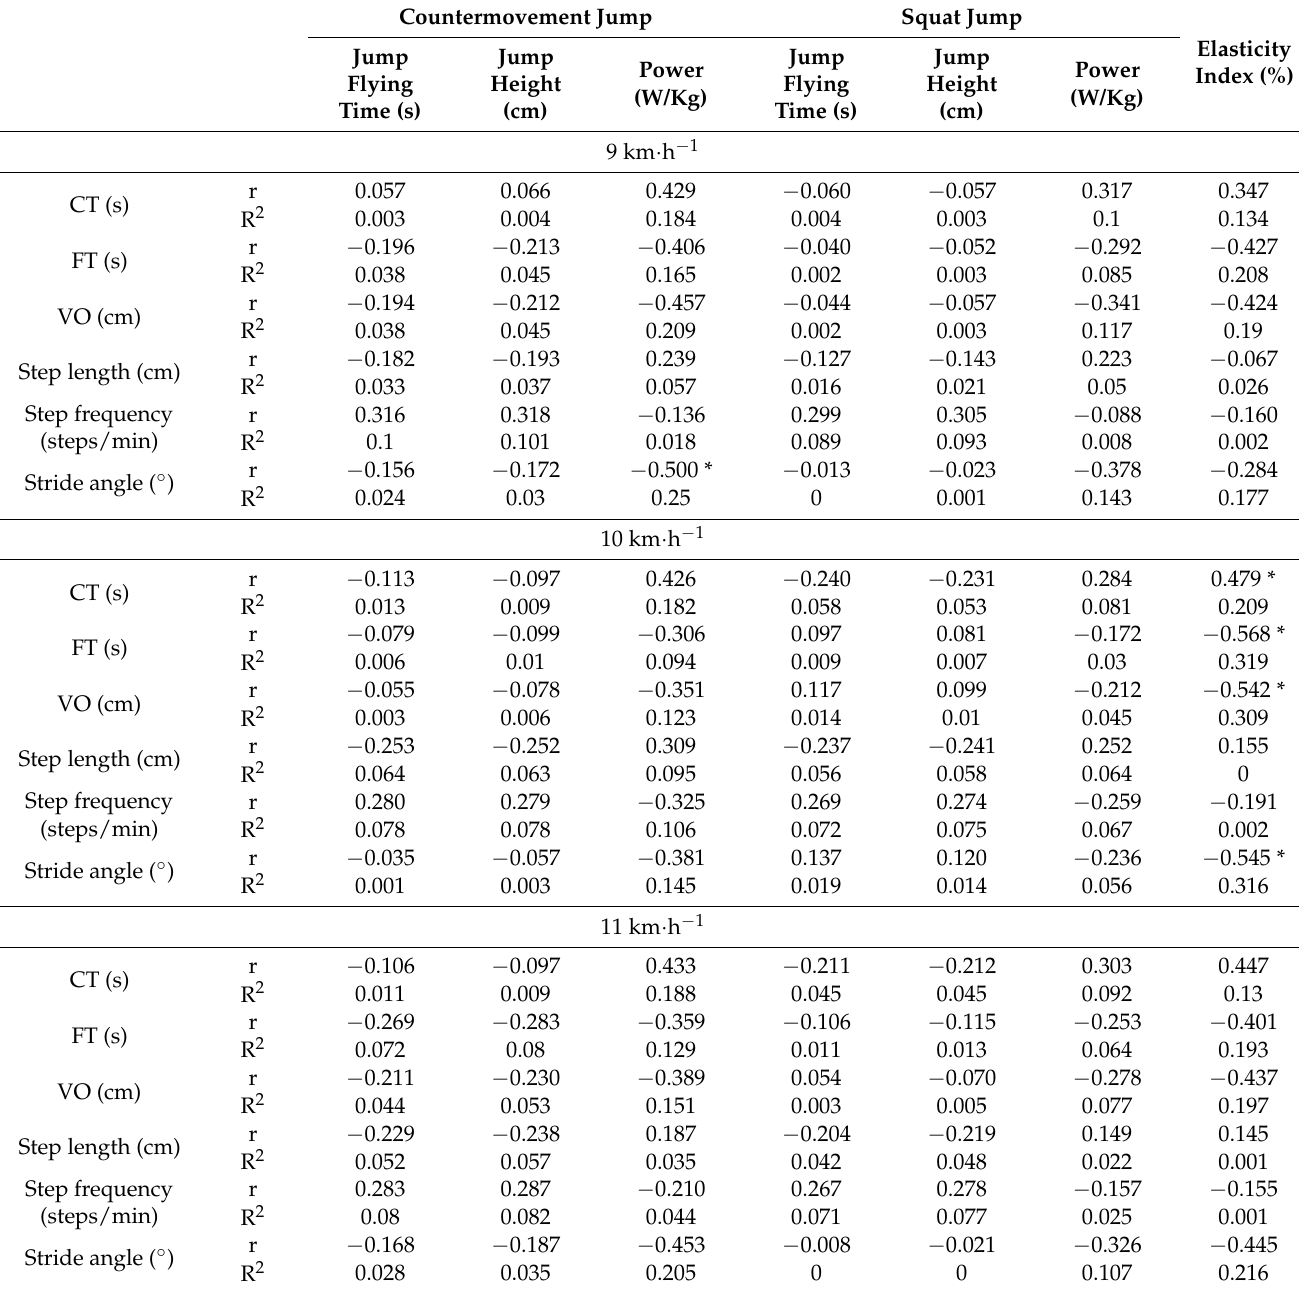
Table 4. Correlation coefficients and estimation of effect size between spatiotemporal biomechanical variables